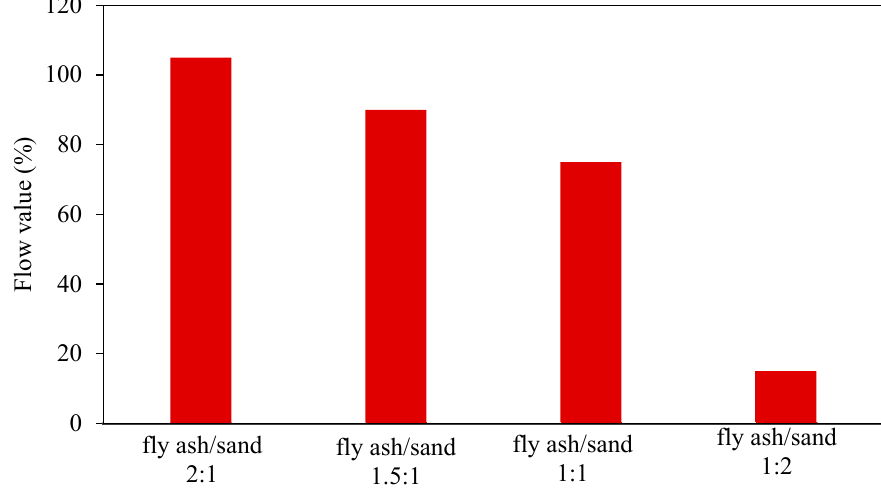
Figure 8. Flow value vs. SiO 2 /Na 2 O ratio in activator [39]. 2.1.2. Fresh Geopolymer Mortar Setting Time Fresh mortar setting time is critical for transporting, casting, and compacting the mortar within the time restriction. The Vicat needle device can be utilised to test the set- ting times per the BS EN 480-2 and ASTM C 807-13 standards [40,41]. The first and final setting times are calculated using the needle’s depth as a reference point, which ranges between 2.5 and 4 mm [41,42]. In order to determine the influence of time after mixing on dielectric properties before heat curing, cast specimens were kept in a laboratory at 28 to 29 °C while being protected from moisture loss by a vinyl sheet geopolymer. The dielectric characteristics of GPM were then measured after being mixed for 24 h [42]. Jumrat et al. [42] investigated the setting time of the specimen’s mixture with the addition of water to obtain the standard flow. The results demonstrate that the weight proportions of NS/NH and FA/AS do not affect the initial and final setup periods. The setting time reduces as NS/NH and FA/AS weight ratios increase, as shown in Figure 9 [24]. By increasing the molarity of NaOH, the initial and final setting times of GPM can be greatly decreased [43]. The setting time reduction in GPM has been attributed to the increased use of PCs. As seen in Figure 10, increased NaOH concentrations caused geopolymer mortars to take longer to set [44].